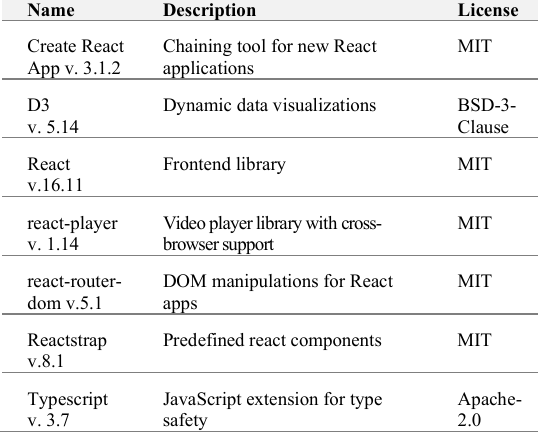
Table 2b. UES-SF questions used in the study (modified from O’Brian et al., 2018)